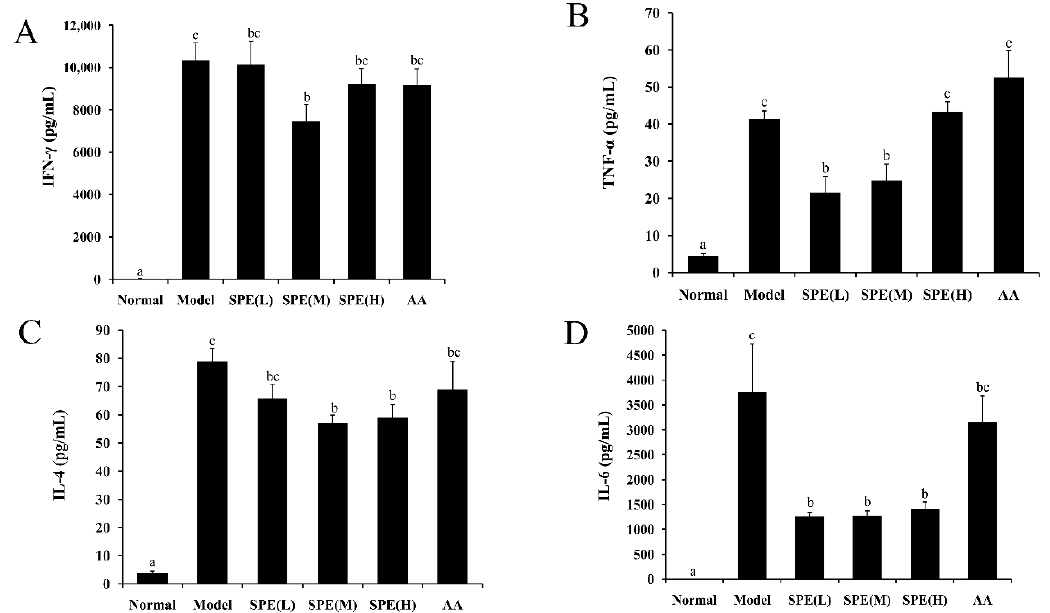
Figure 5. The effects of sheep placental extract (SPE) on the concentration of IFN- γ ( A ), TNF- α ( B ), IL-4 ( C ) and IL-6 ( D ) in serum. Values are represented as means ± SE ( n = 11). a, b, c and bc in the figures indicate statistically significant differences ( p < 0.05) among groups. The experimental groups pretreated with low dose SPE (5 mg/kg), medium dose SPE (10 mg/kg), high dose SPE (50 mg/kg) or the mixture of 18 amino acids equal to the 50 mg/kg SPE group are labelled as SPE (L), SPE (M), SPE (H) and AA, respectively.